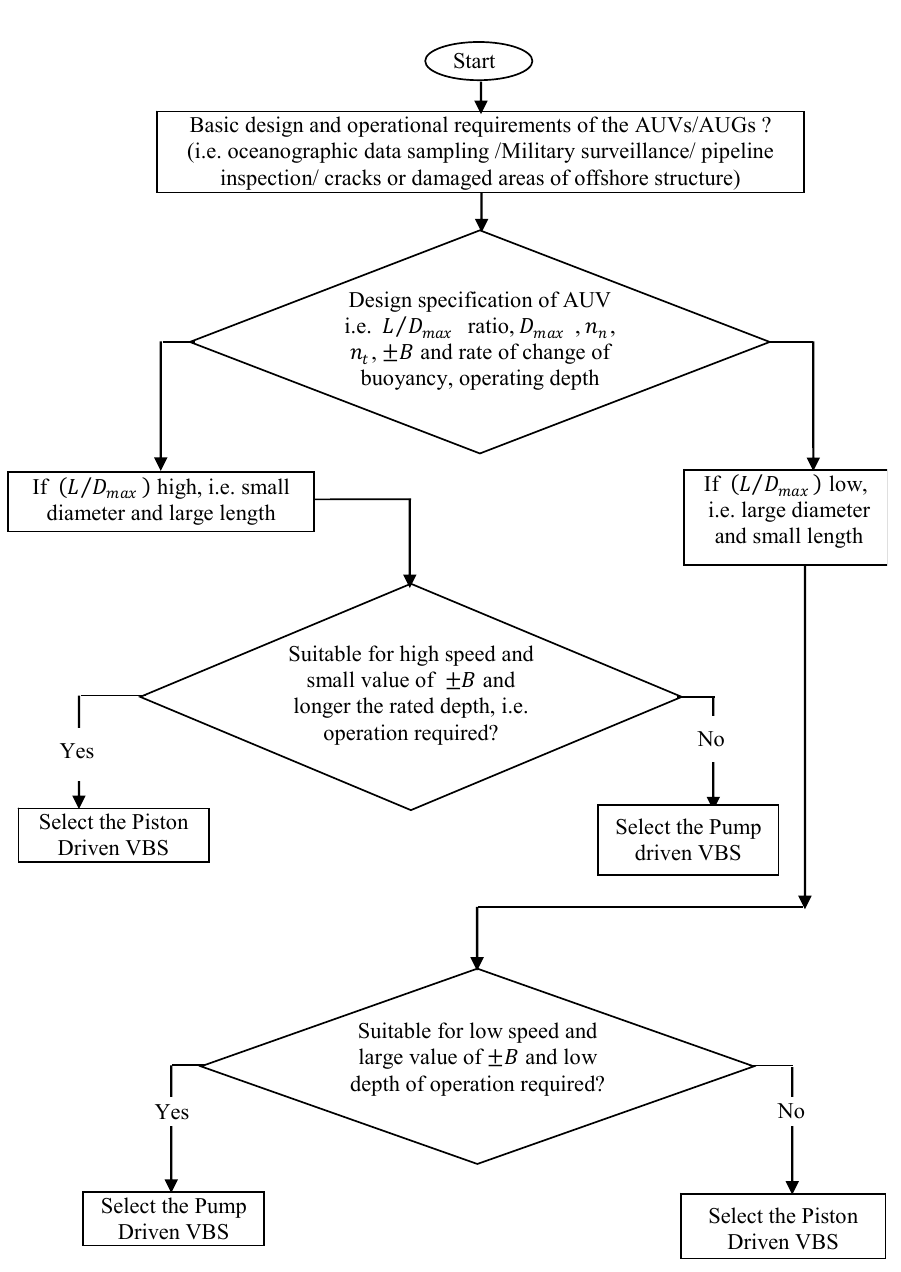
Figure 3. Our complete approach for the design and selection of the VBS.